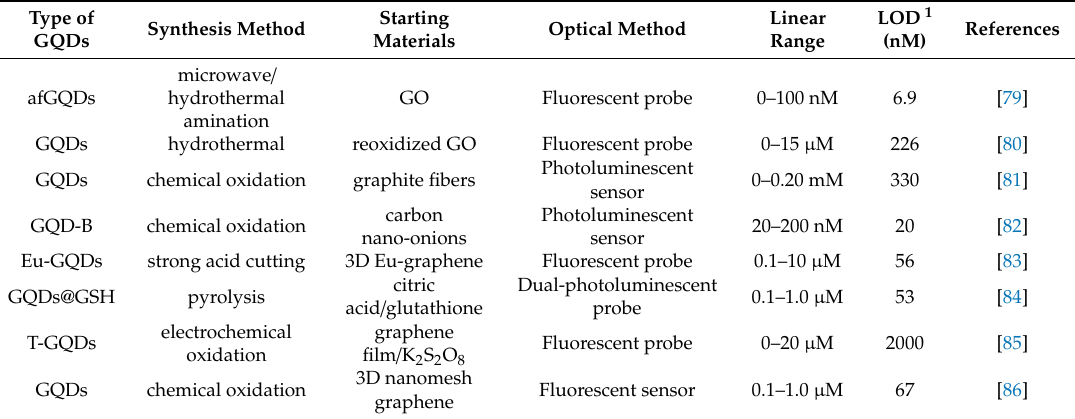
Table 5. The GQDs-based optical sensor for copper ion